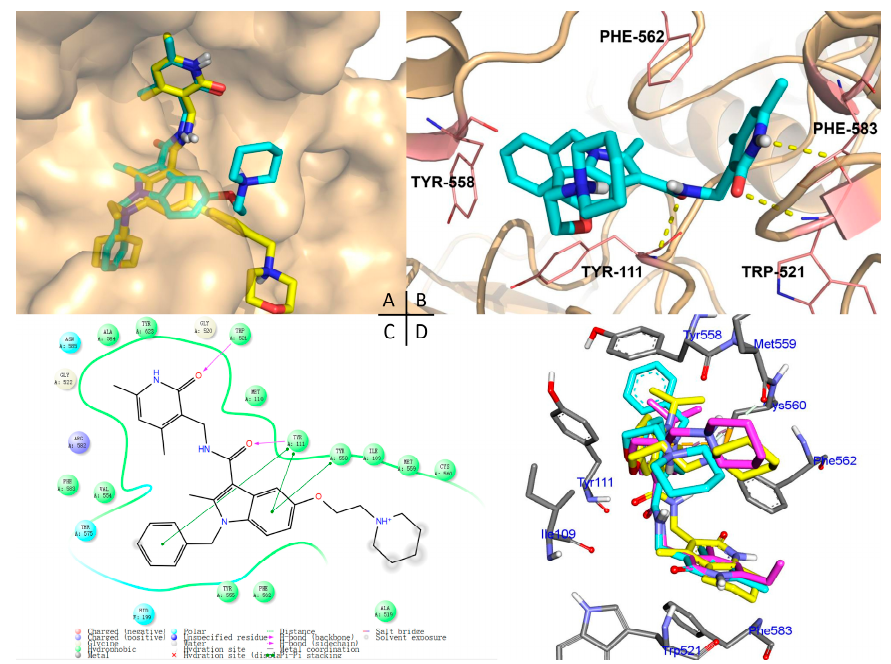
Figure 4. Molecular modeling of 5-hydroxyindole-based inhibitors bound to EZH2 (Note: PDB ID 4W2R). ( A ) Binding pocket surface of L – 04 (light blue) and tazemetostat (yellow); ( B ) Binding pose of L – 04 . Hydrogen bond contacts are shown with dashed lines and small molecules are shown as sticks; ( C ) Binding interaction of L – 04 ; ( D ) Overlay of L – 04 (light blue), L – 19 (pink) and L – 22 (light yellow) docking